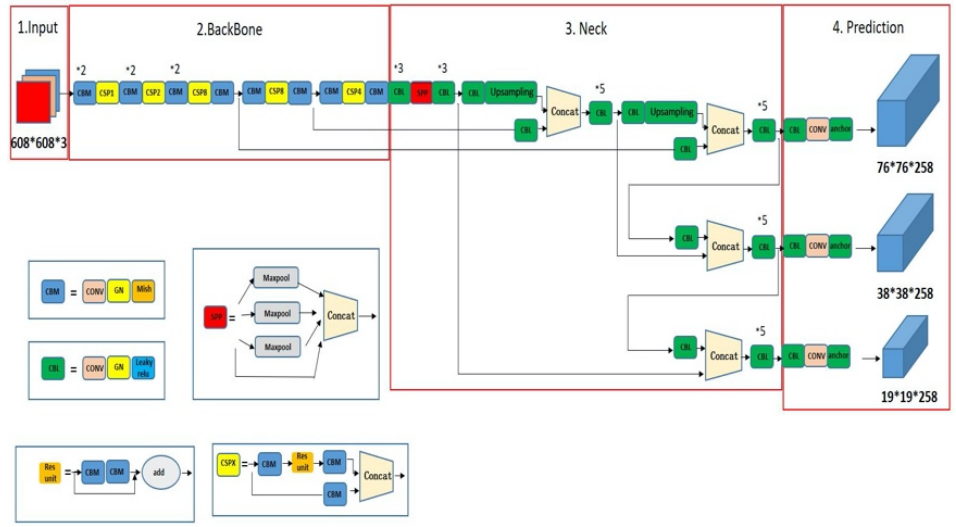
Figure 2. The architecture of one-stage detector based on background prediction and group normalization.